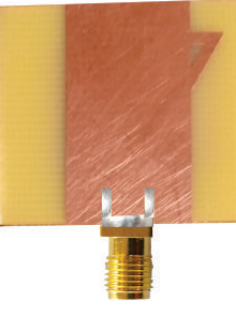
FIGURE 15. Ground plane of the fabricated HGWMPA.